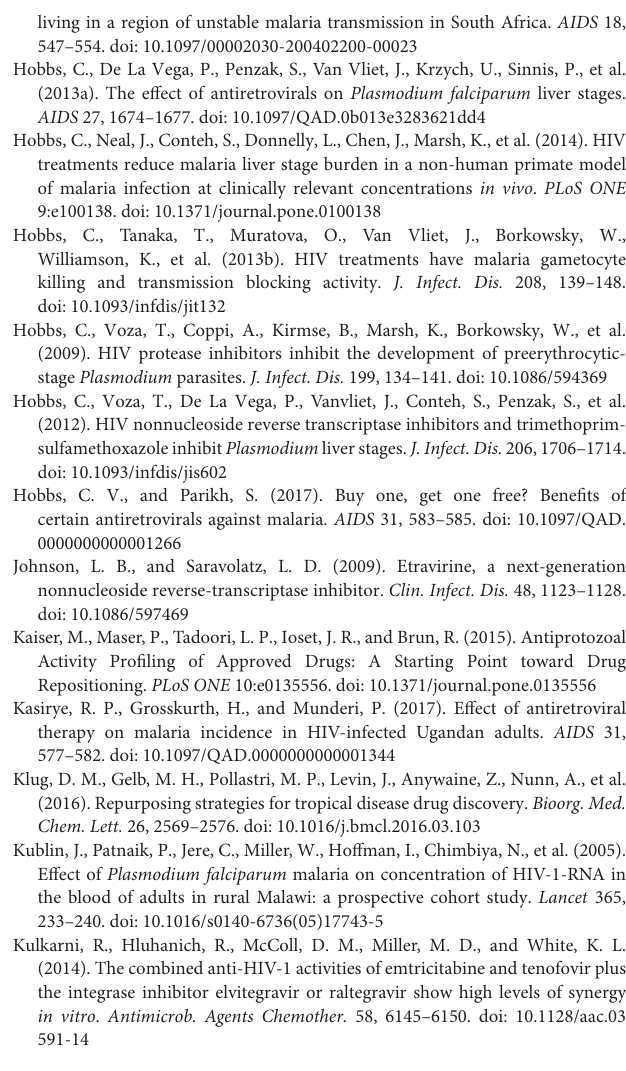
Supplementary Figure 1 | In vivo experimental setup. (A) Schedules and doses of administration of antiretroviral drugs. (B) Schematic illustration of the in vivo experimental setup, highlighting the schedules of drug treatment